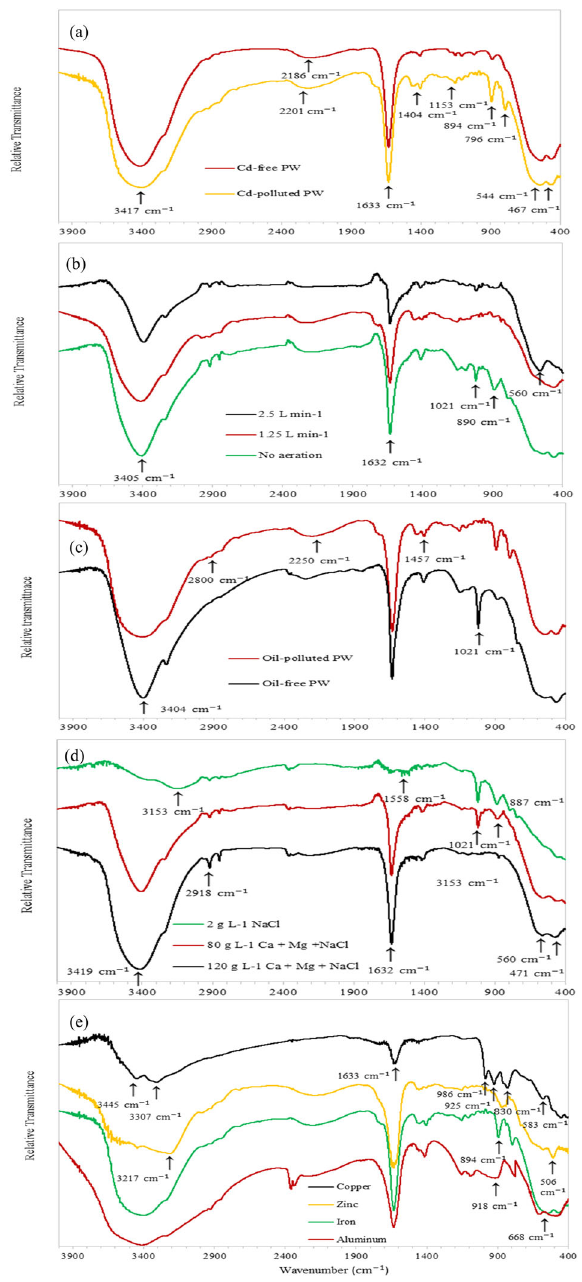
Fig. 3 FTIR spectra of the electro-generated metal hydroxide particles at various conditions. a Cd-free and Cd-polluted PW; b with/without aeration; c with/without oil; d different salinities; e four electrode materials. (Experimental conditions: pH 7, current density 25 mA cm − 2 , salinity 43.5 g L − 1